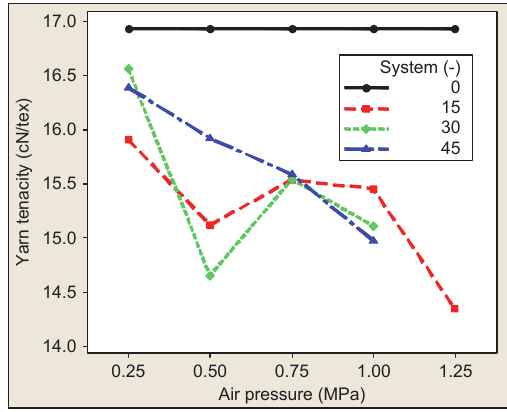
Figure 10 Yarn tenacity results.